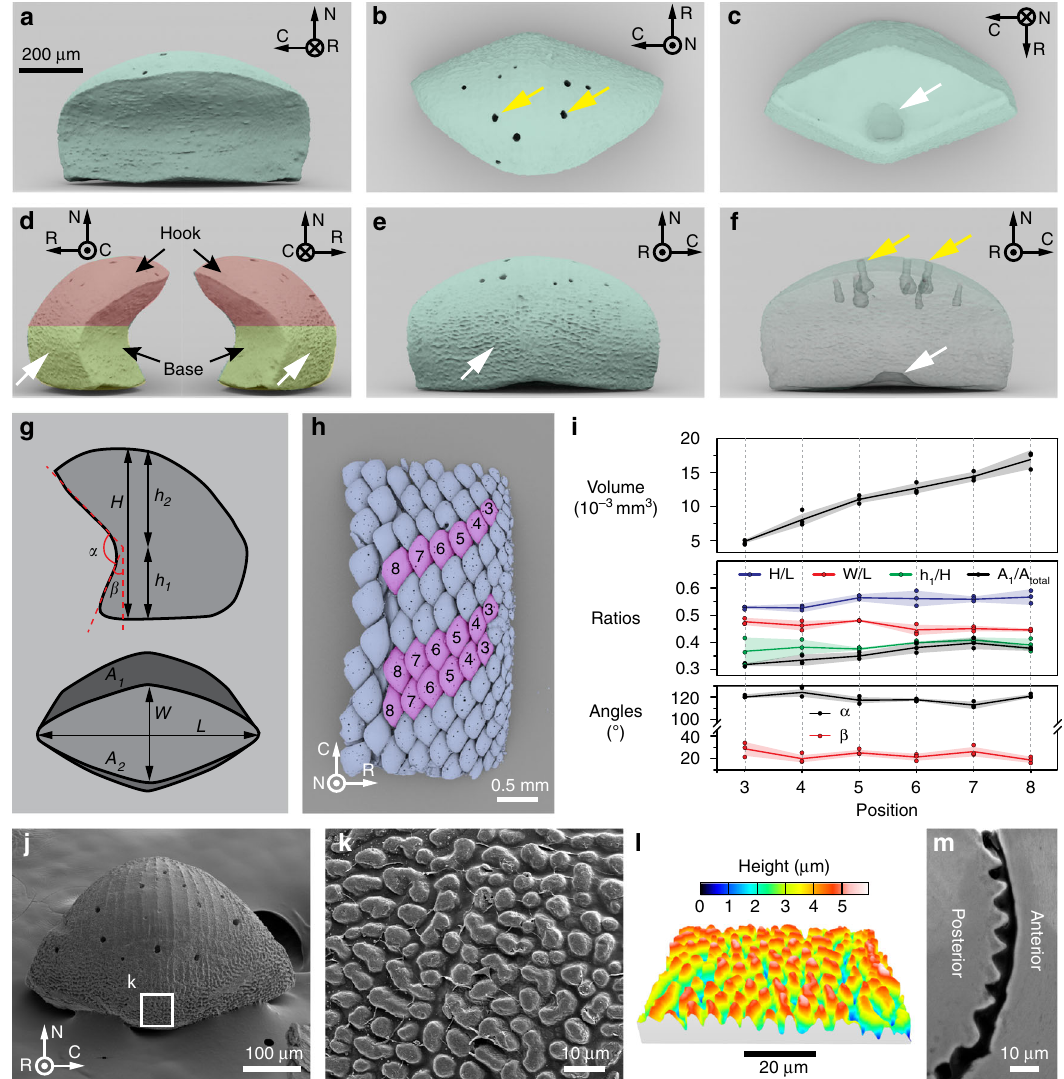
Fig. 3 Three-dimensional geometry and surface morphology of individual dorsal scales of the chiton R. canariensis . a – f μ -CT data-based 3D rendering of individual girdle scales in different view angles and modes: a front view, b top view (yellow arrows indicate pore openings), c bottom view (white arrow shows a depression at the base of the scale), d two side-views (white arrows shows the surface roughness at the lower surface of backside), e back view, and f transparent mode (the yellow arrows show holes in the dorsal surface of scales and the white arrow indicates depression in base). g Projection contours along two orientations (transverse and bottom) are used to describe the geometries of chiton scales. Geometrical parameters are de fi ned, including lengths ( w , l , h 1 , h 2 , h ( = h 1 + h 2 )), angles ( α and β ), areas ( A 1 , A 2 , and A total ( = A 1 + A 2 )), and volumes ( V ). h Top view of a μ -CT data-based reconstruction of the girdle scale assembly of R. canariensis . Three columns of scales used in the geometrical measurement are highlighted in pink color and their positions are indicated. i Variations of geometrical parameters as a function of scale position. The solid line represents the average and the shaded area shows the standard deviation ( N = 3 for each measurement). j SEM image of a scale ’ s back surface. k Magni fi ed-view of scale surface with microscopic bumps at the underside of the back surfaces of chiton scales, as indicated by the white box in j . l SEM-derived stereographic reconstruction of microscopic bumps in a similar region shown in k . m Backscattered SEM image of a polished cross-section in the region of microscopic bumps of a scale, highlighting the difference in morphology between the anterior (front) and posterior (back) surfaces of the dorsal β (describing the lateral pitch of the base), and two projection areas A 1 and A 2 (Fig. 3g). Morphometric measurements from three rows of dorsal scales within the girdle scale assembly were conducted (Fig. 3h), and the results are summarized in Fig. 3i. The scale size gradually decreases from the proximal to distal margins, as indicated by the decrease of scale volume from ca. scales are roughly geometrically similar, as evidenced by the consistency of all parametric ratios ( H/L , ca. 0.5 – 0.6; W/L , ca. (Fig. 3d, e). Figure 3k shows that the roughness of the posterior 0.4 – 0.5; and h 1 /H , ca. 0.3 – 0.4), angles ( α , ca. 110 – 120° and β , ca. surface is caused by evenly distributed cone-shaped protrusions,